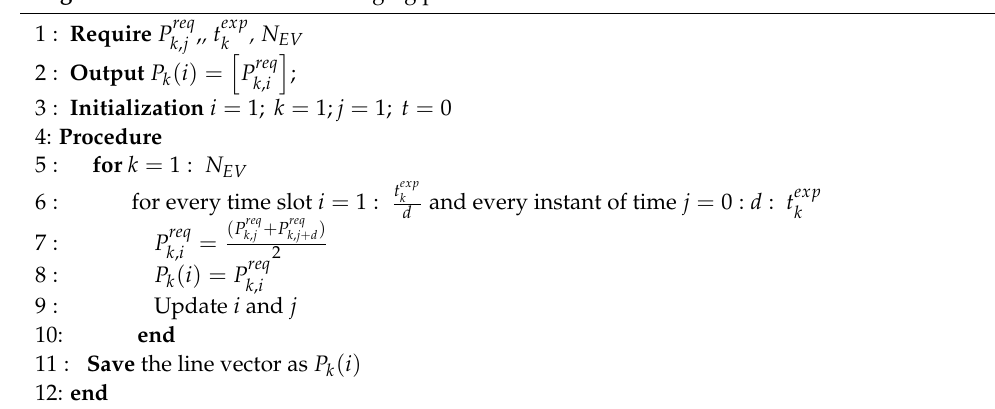
Algorithm 1 discretization of charging profile